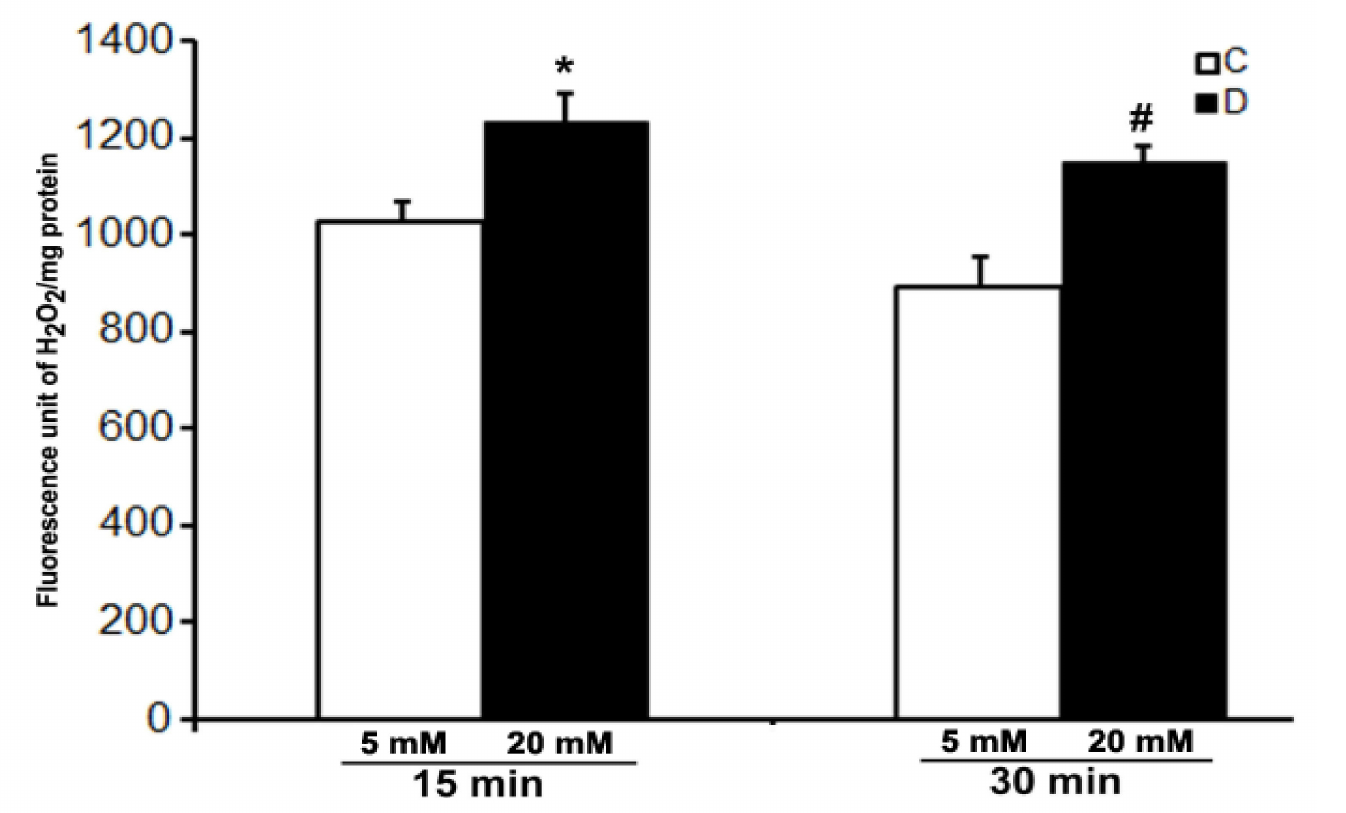
Figure 4. Effect of CuSO 4 on the H 2 O 2 level in excised control and diabetic rat retinas. 10-week diabetic retinas were incubated in Krebs bicarbonate buffer with 20 mM glucose, and their age-matched euglycemic controls were incubated with 5 mM glucose. H 2 O 2 measurement was done in the buffer after 15 and 30 min of 10 µ M CuSO 4 treatments. The content of the retinal protein was determined for each incubation. Values are means ± SEM for 5 determinations (n = 5 for each). * ,# p < 0.05, diabetic versus control